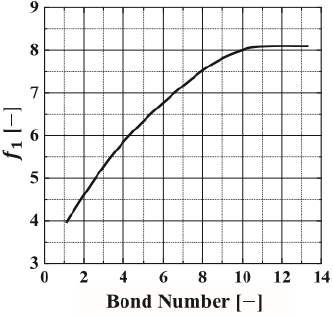
Figure A1. Variation of factor f 1 with the Bond number [27,28].